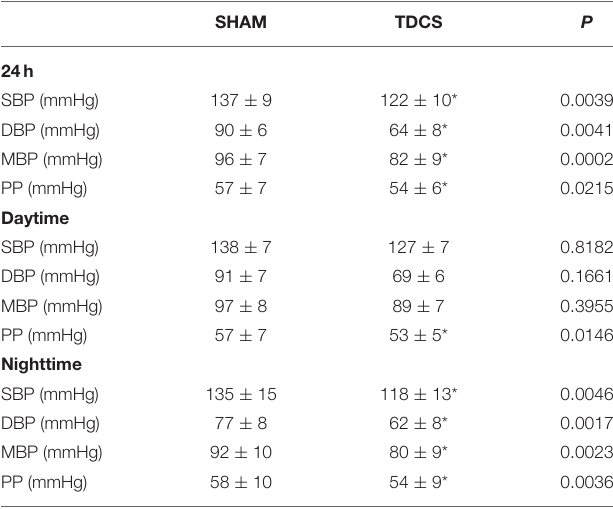
TABLE 3 | Acute intervention: 24-hs-ambulatory blood pressure measurements (ABPM) in resistant hypertensive patients after SHAM or tDCS conditions.